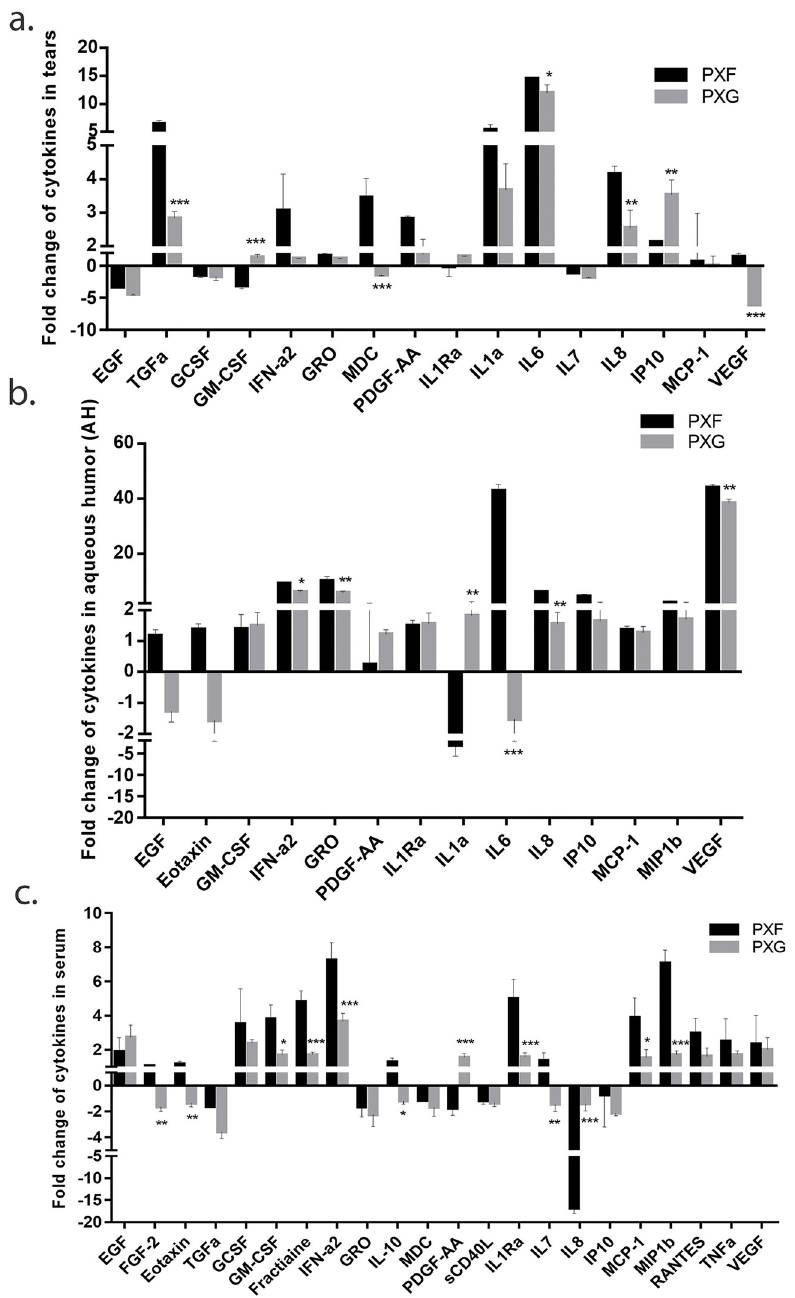
Fig 3. Cytokines/chemokines profile in tears, aqueous humor and serum samples. Graph shows the fold change of cytokines in 10 pooled tears in one (n = 20) aqueous humor (n = 3) and serum samples (n = 3) by multiplex bead assays. PXF- pseudoexfoliation, PXG- pseudoexfoliation glaucoma. Means ± SEM shown, � p < 0.05, �� p < 0.01, ��� p < 0.001, one way ANOVA post hoc t test with Turkey correction, PXF- pseudoexfoliation, PXG- pseudoexfoliation